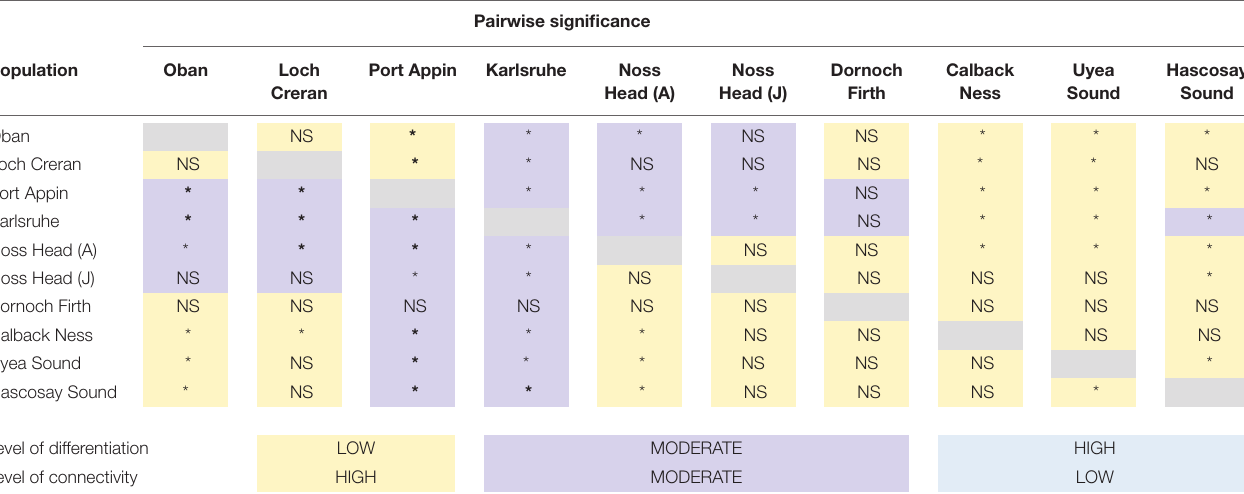
TABLE 4 | Level (low, moderate, and high) and significance of genetic differentiation values for Scottish M. modiolus reefs. Pairwise significance